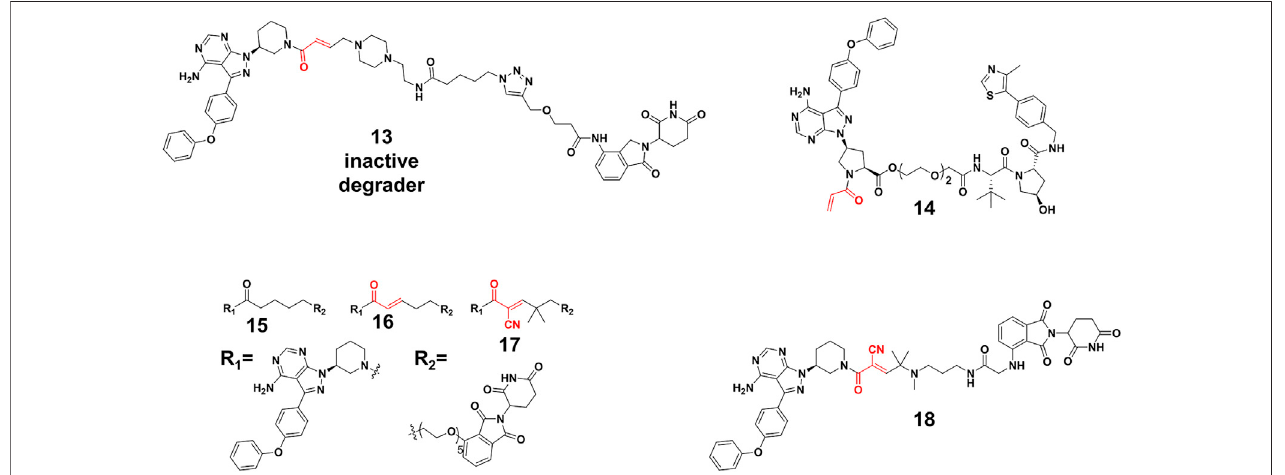
FIGURE 6 | Chemical structures of irreversible covalent, noncovalent, and reversible covalent PROTACs.